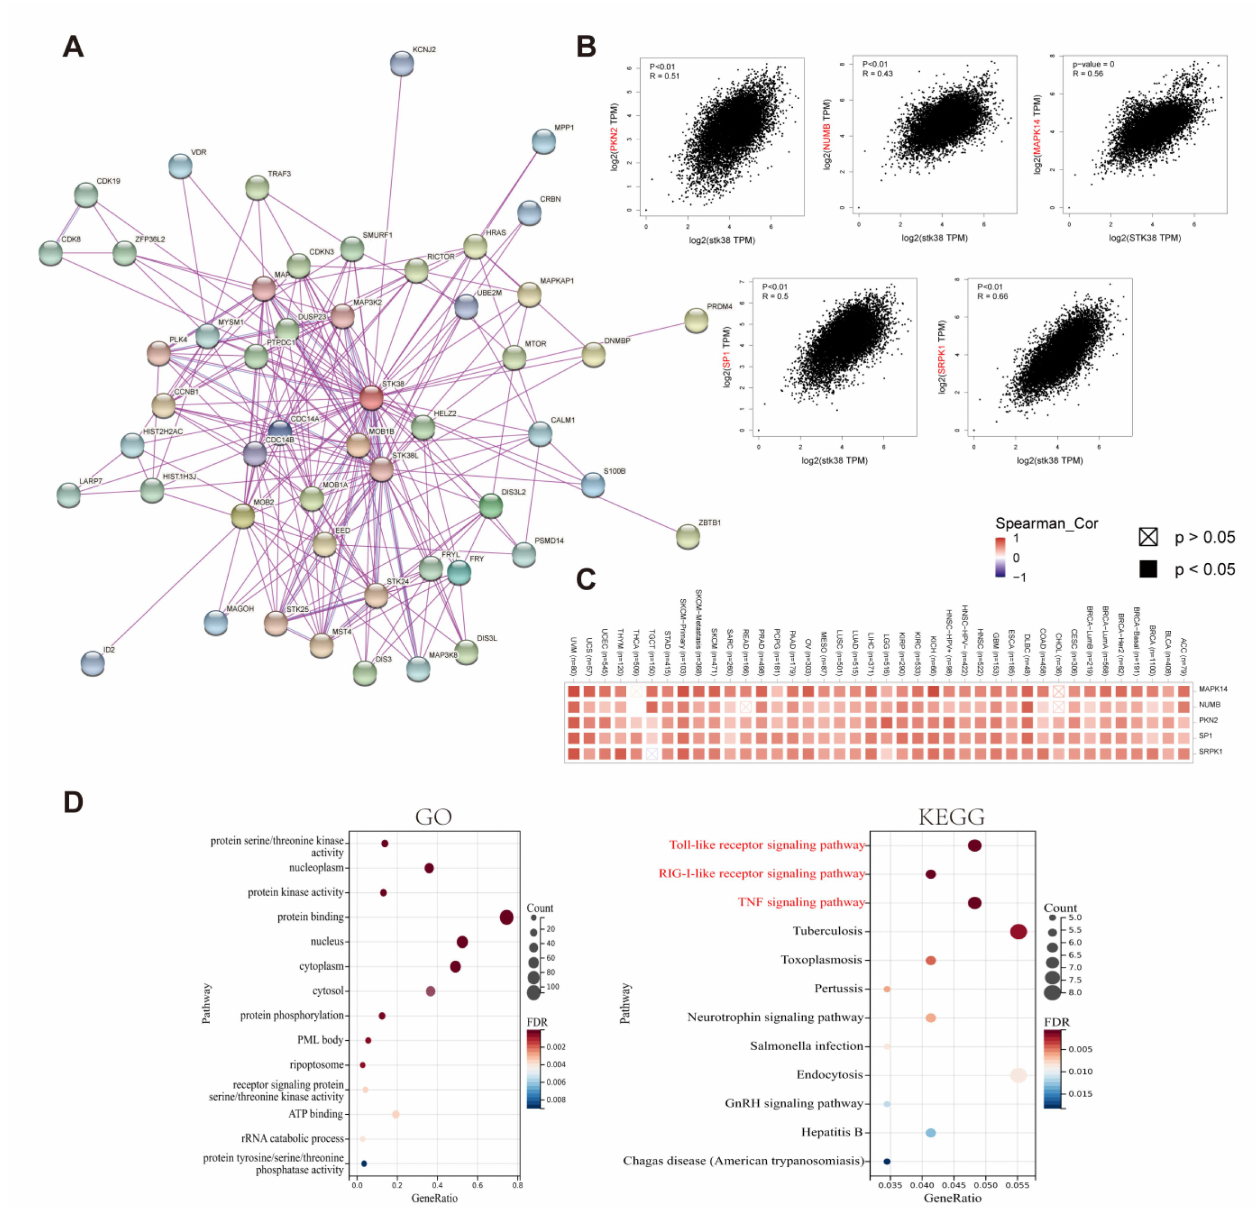
Figure 7. Enrichment and pathway analysis of STK38-related partners. ( A ) The experimentally verified STK38-binding proteins were obtained from the STRING website. ( B ) The correlation analysis between STK38 and selected binding genes including PKN2, NUMB, MAPK14, SP1 and SRPK1 using the GEPIA2 tool. ( C ) The corresponding heatmap data of different cancer types are displayed in detail. ( D ) GO and KEGG pathway analysis were performed based on the STK38 -binding and interacted